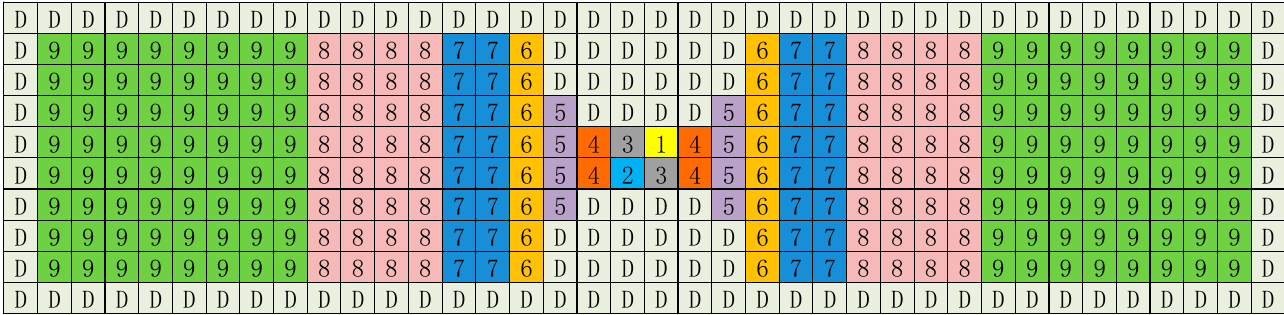
Figure 10. The layout floorplan of the DAC capacitor array.